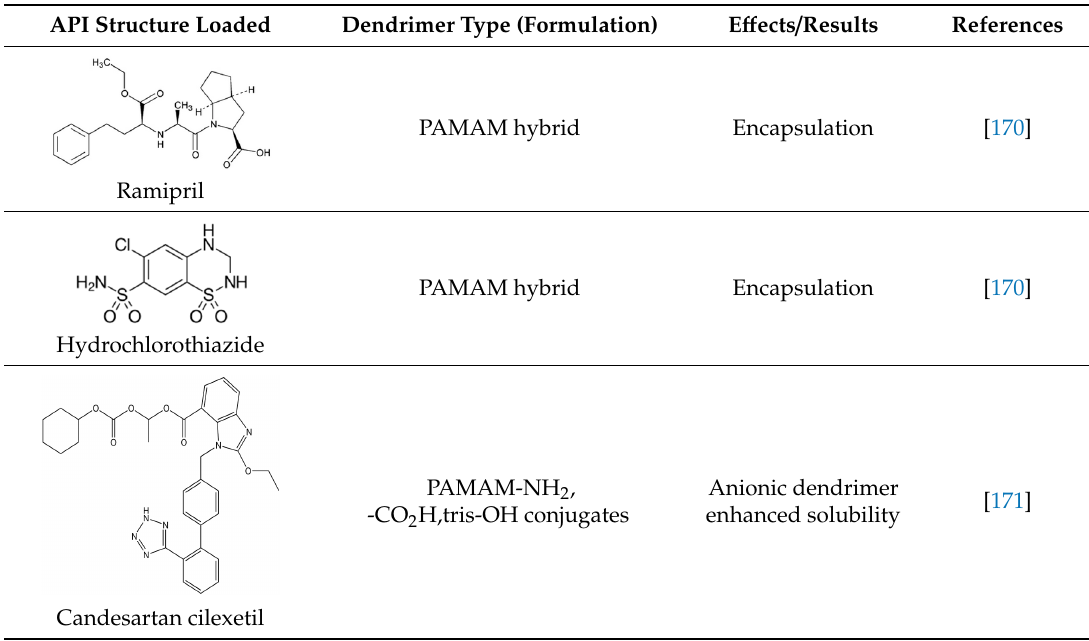
Table 4. Anti-hypertensive Drugs.